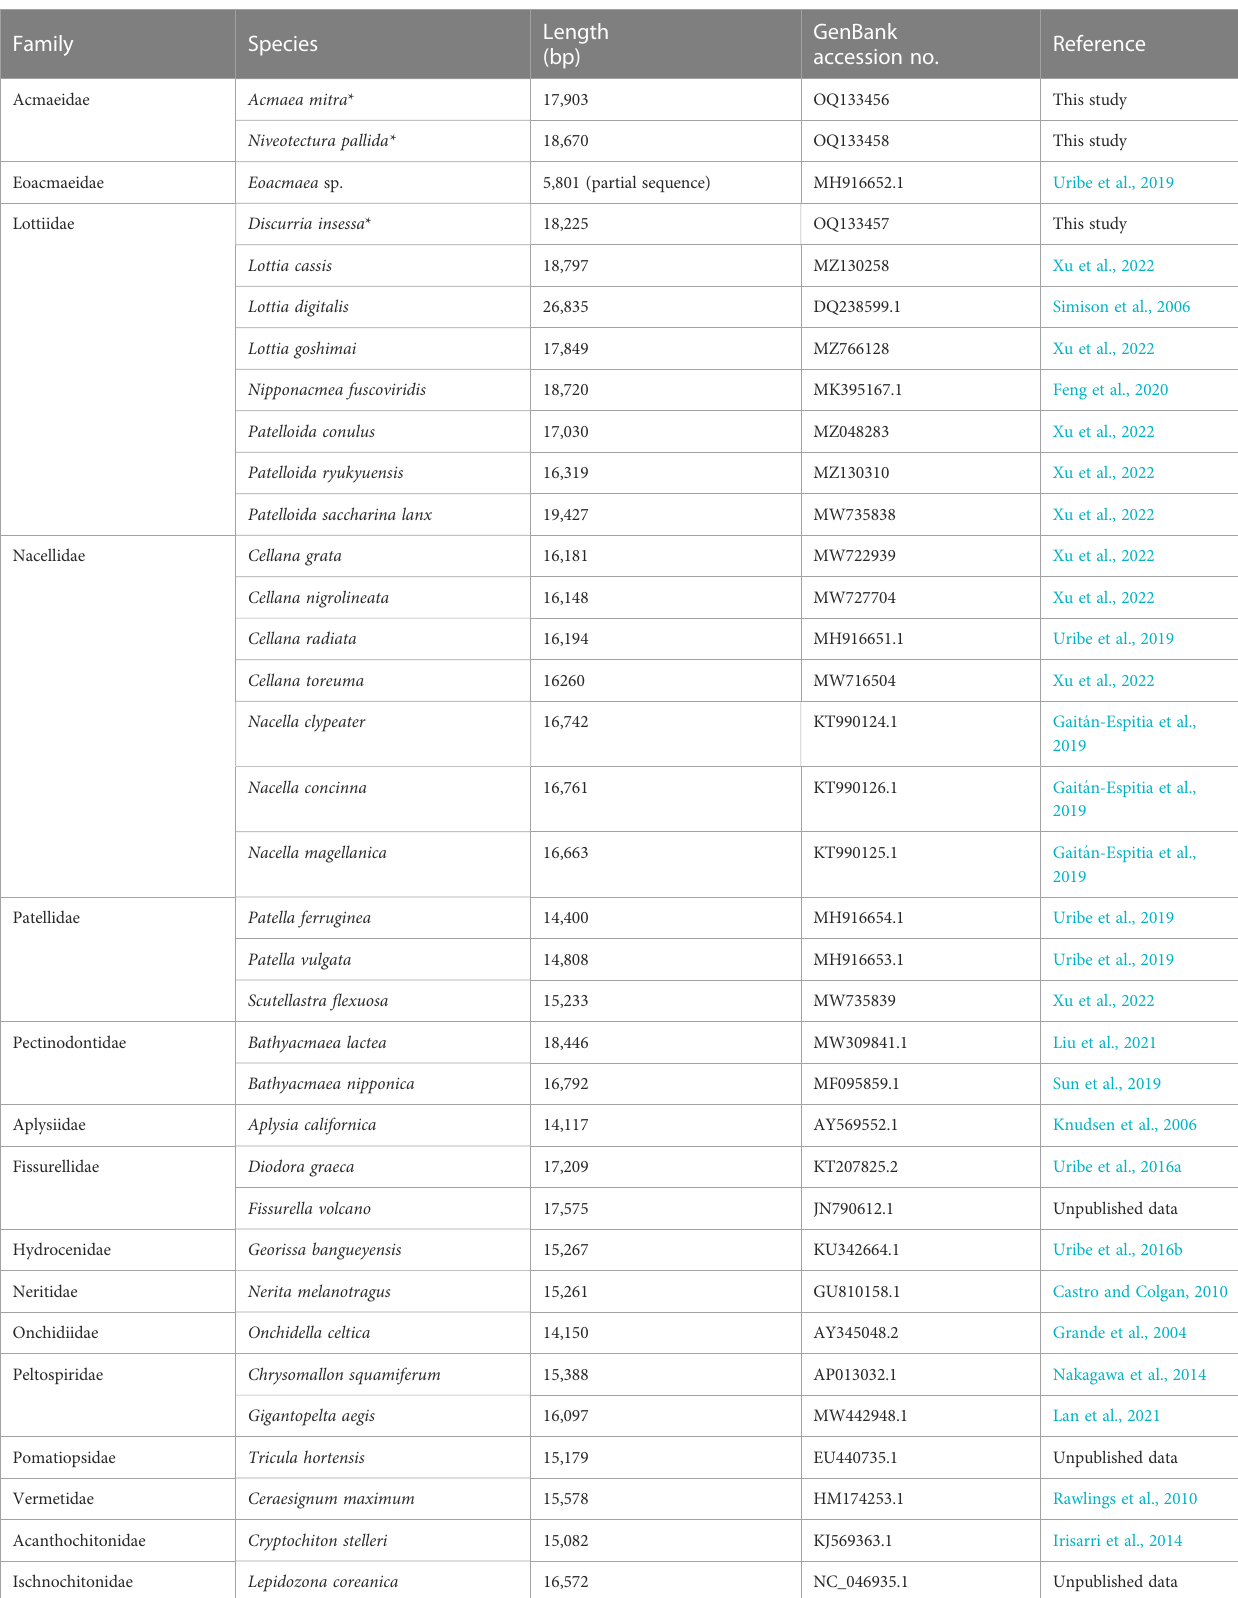
TABLE 1 Complete mitochondrial genomes used for phylogenetic analysis in this